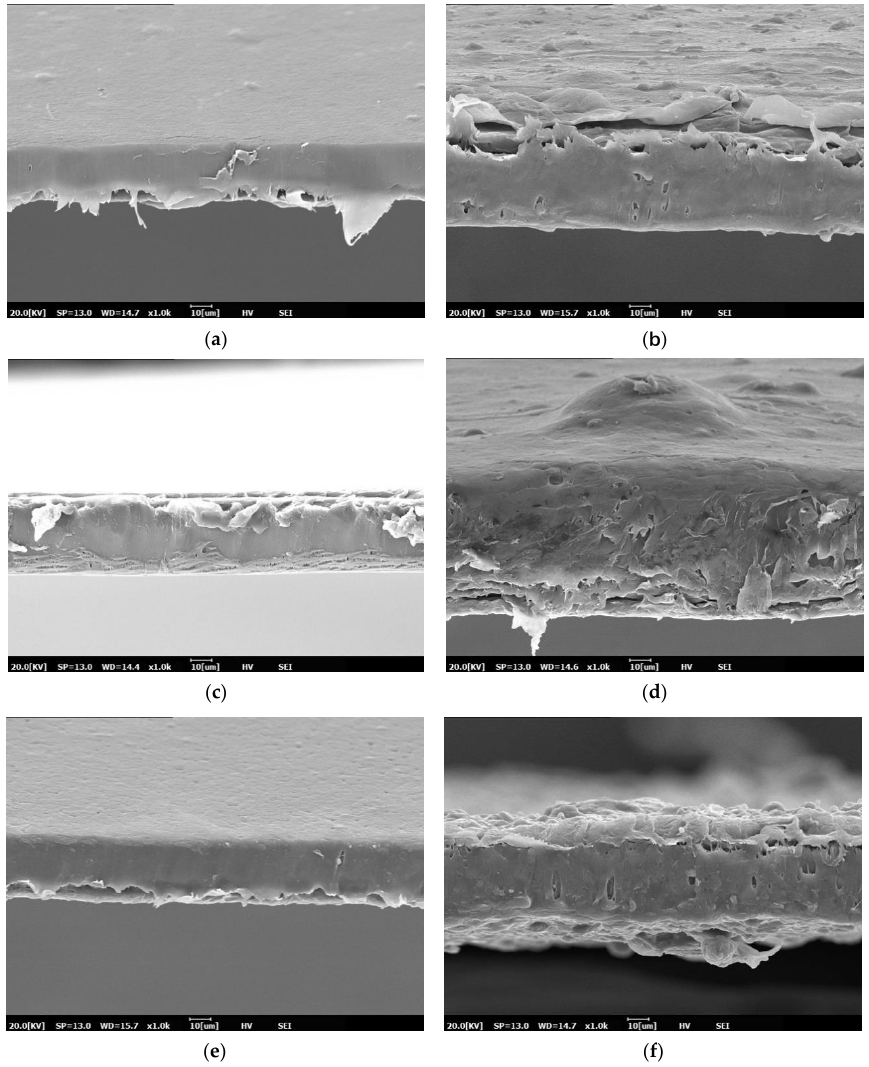
Figure 1. SEM images of cross-sectional morphology for film samples of ( a ) PBS, ( b ) PBS 1.5% BM, ( c ) PBS 3% BM, ( d ) PBS/TPS, ( e ) PBS/TPS 1.5% BM, and ( f ) PBS/TPS 3% BM under ×1000 magnification viewing.